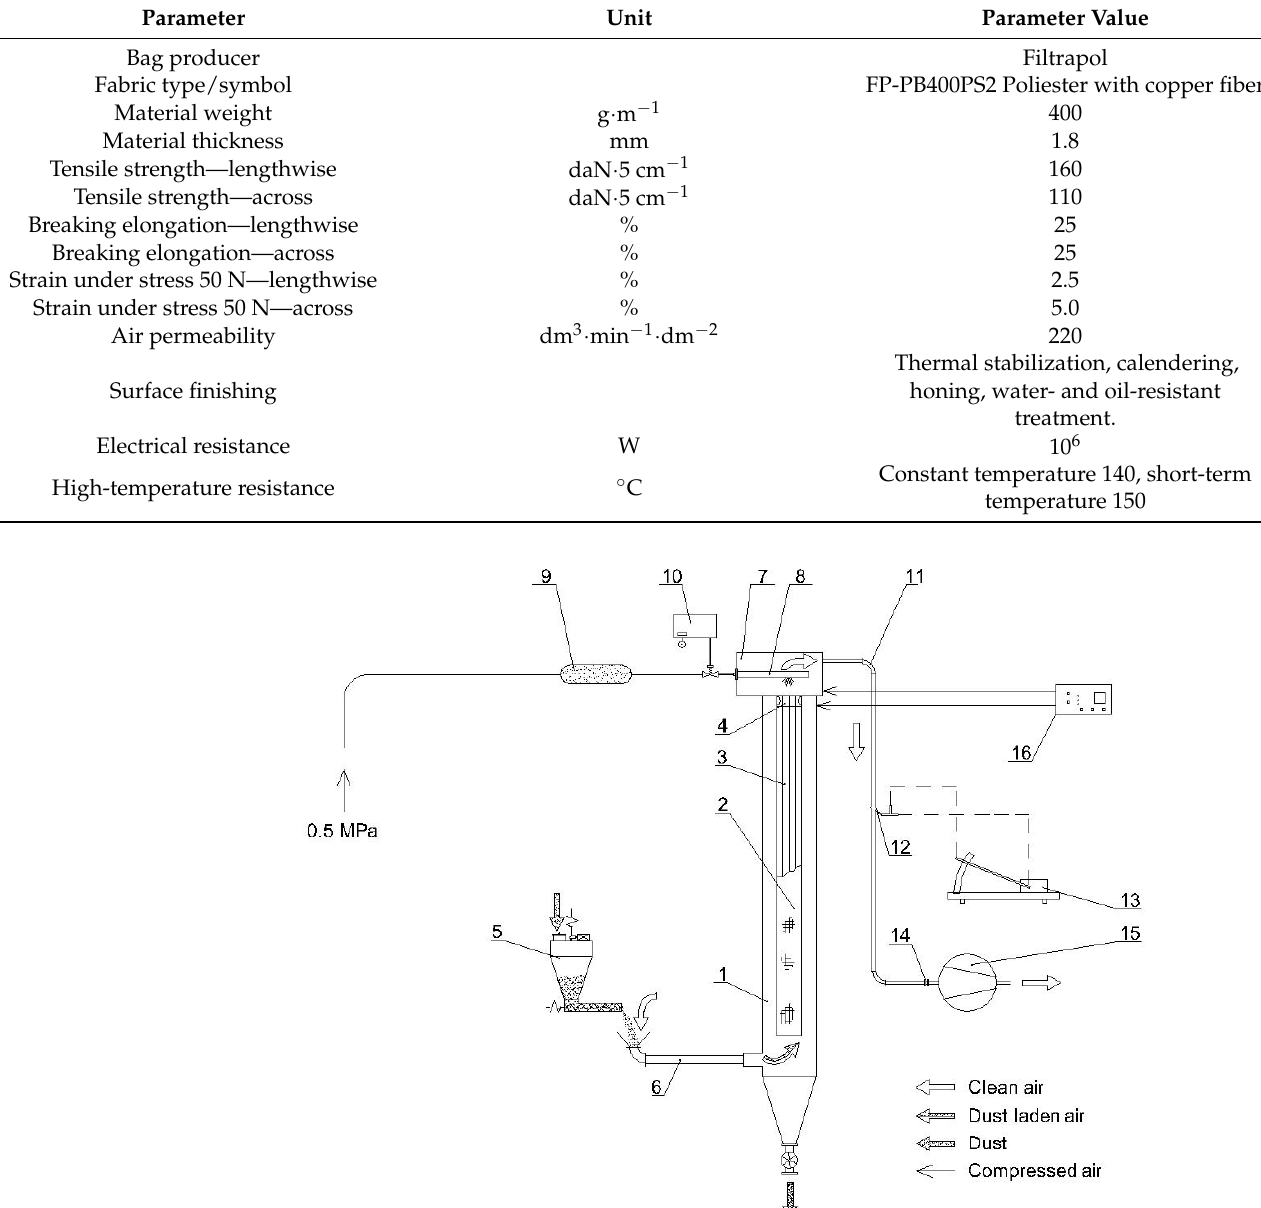
Table 3. Basic technical properties of the filter bags according to the manufacturer (material A).